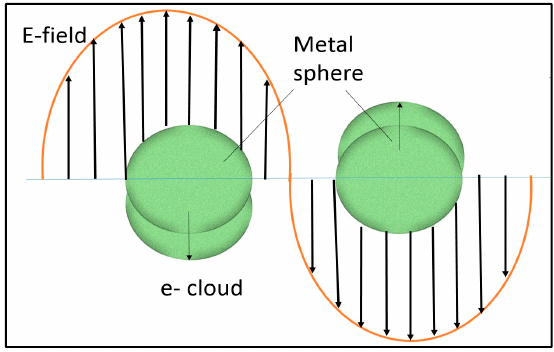
Figure 4. The schematic diagram is representing surface plasmon resonance in a spherical metal particle induced by the electric field component of incident light (adapted from [138]).